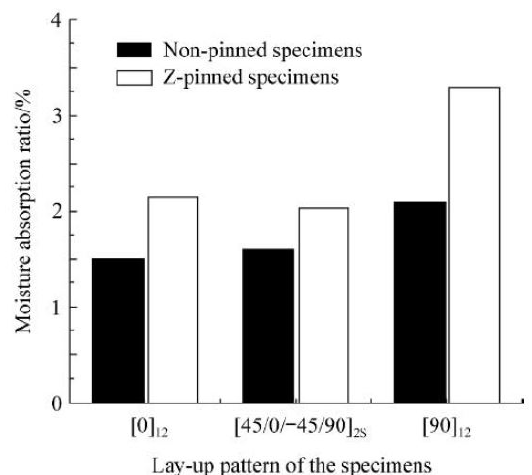
F igure 69. Effect of z-Pin content on compressive strength in quasi-isotropic laminates in both RTD and Hygrothermal environment [42].